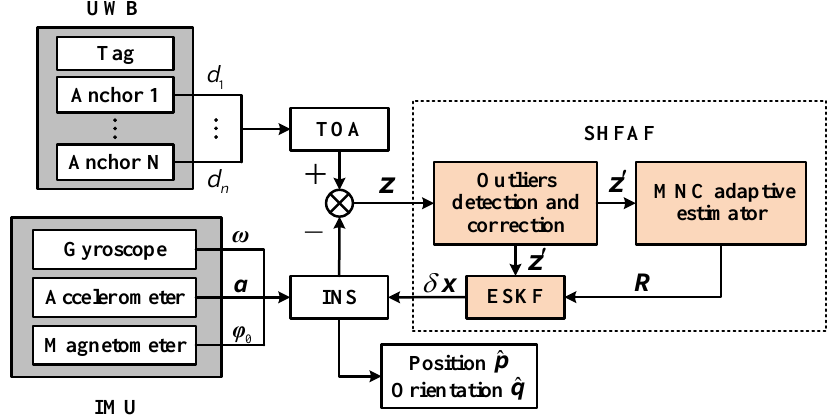
Figure 2. The framework of robust inertial navigation systems (INS)/ultra wideband (UWB) integrated positioning